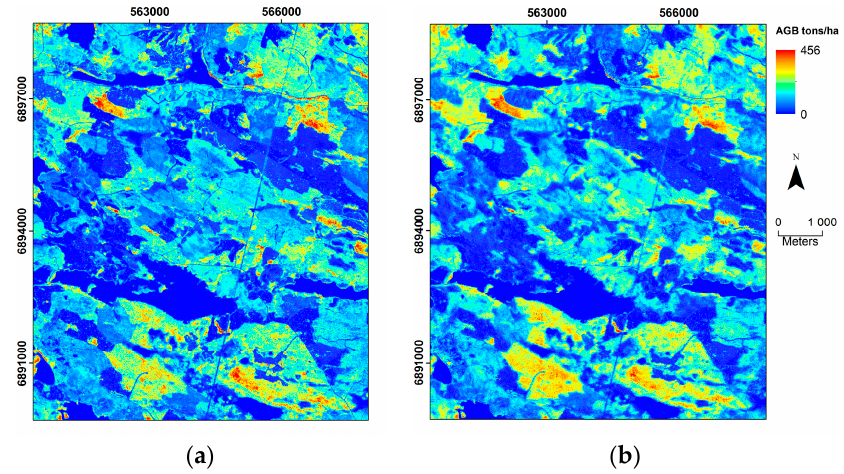
Figure 19. ( a ) ALS 2015-based AGB map by SLU and the Swedish Forest Agency [3] ( b ) TanDEM-X October 2015-based AGB map.